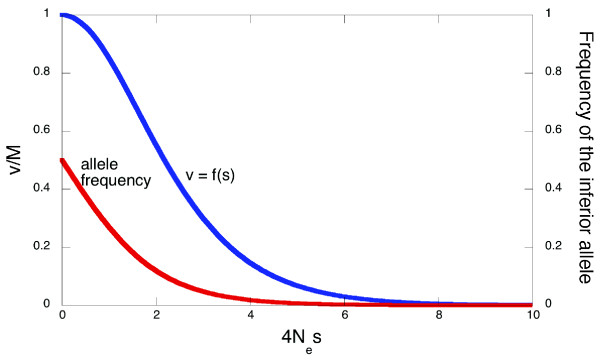
Rate of evolution and frequency of the inferior allele as functions of 4Nes. Rate of evolution v is in the units of rate of neutral evolution M [13].